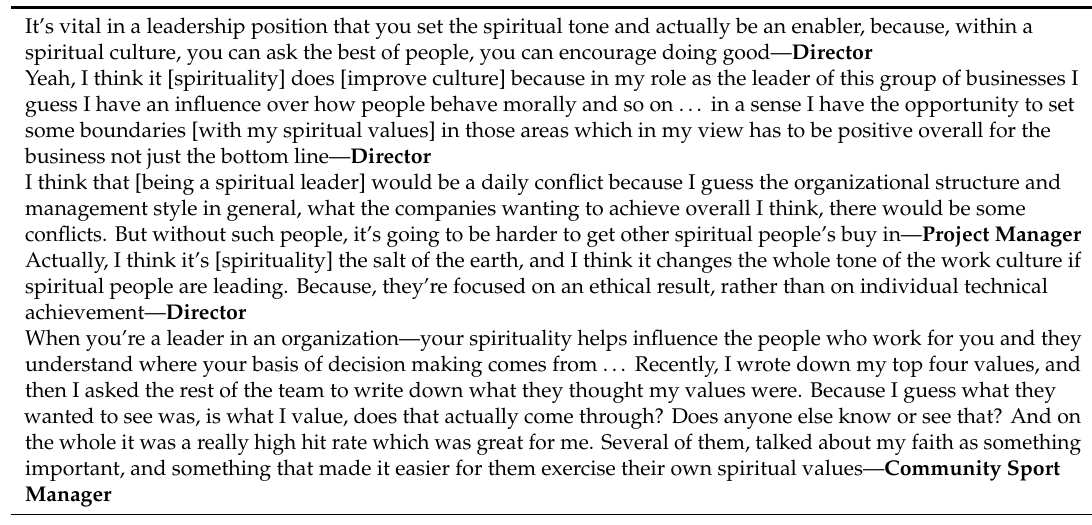
Table 5. Extracts in support of Condition 4— Supportive Spiritual Leadership